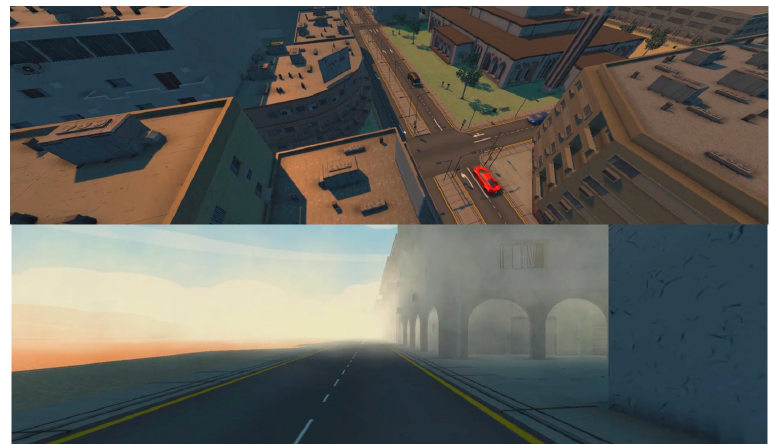
Figure 6. Overall image of the created 3D city with vehicles and pedestrians ( top ) and recreated poor environmental conditions, which difficult driving ( bottom ).